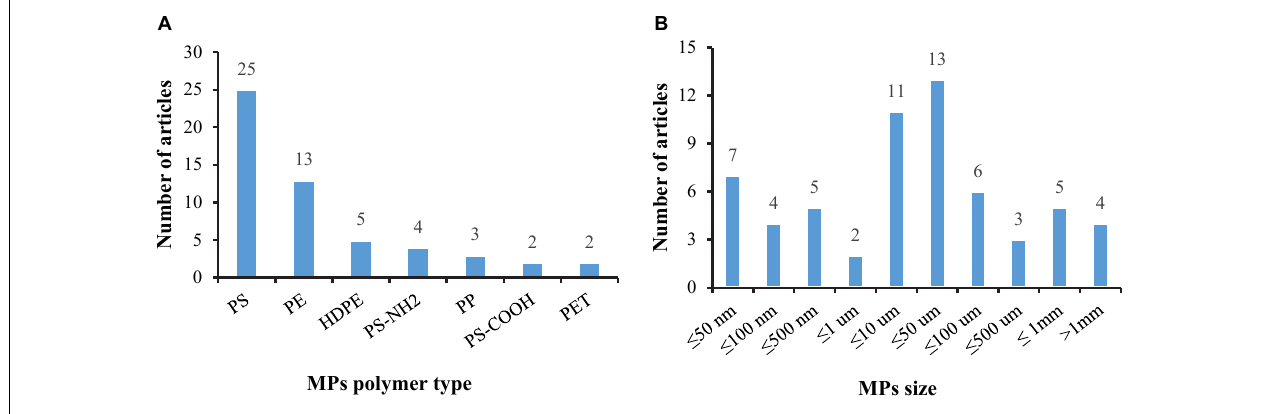
FIGURE 2 | The number of articles that have tested MPs in bivalves according to the polymer type and size: (A) Description of MPs polymer type is contained in the first panel; (B) Description of MPs size is contained in the second panel.